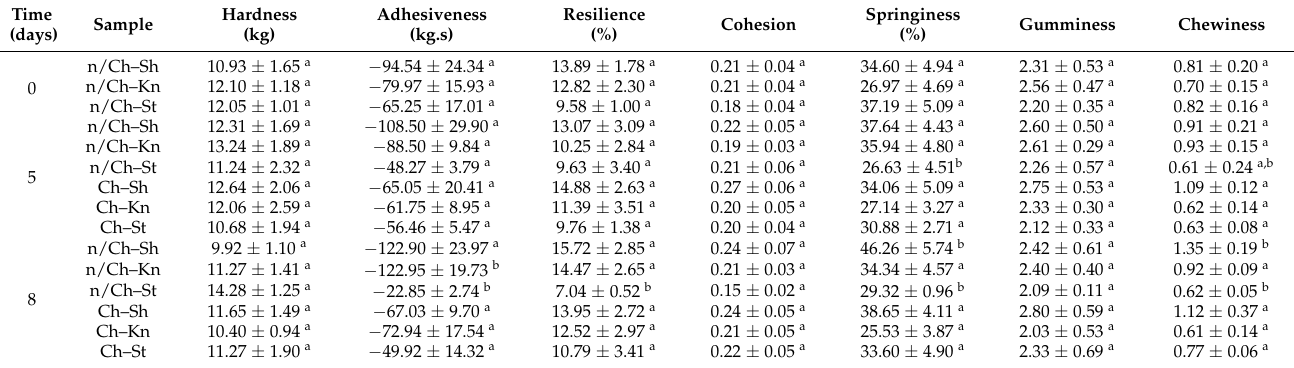
Table 3. Texture parameters (hardness, adhesiveness, resilience, cohesion, springiness, gumminess and chewiness) obtained for the different coated and non-coated beef cuts (Sh, Kn and St) on days 0, 5 and 8